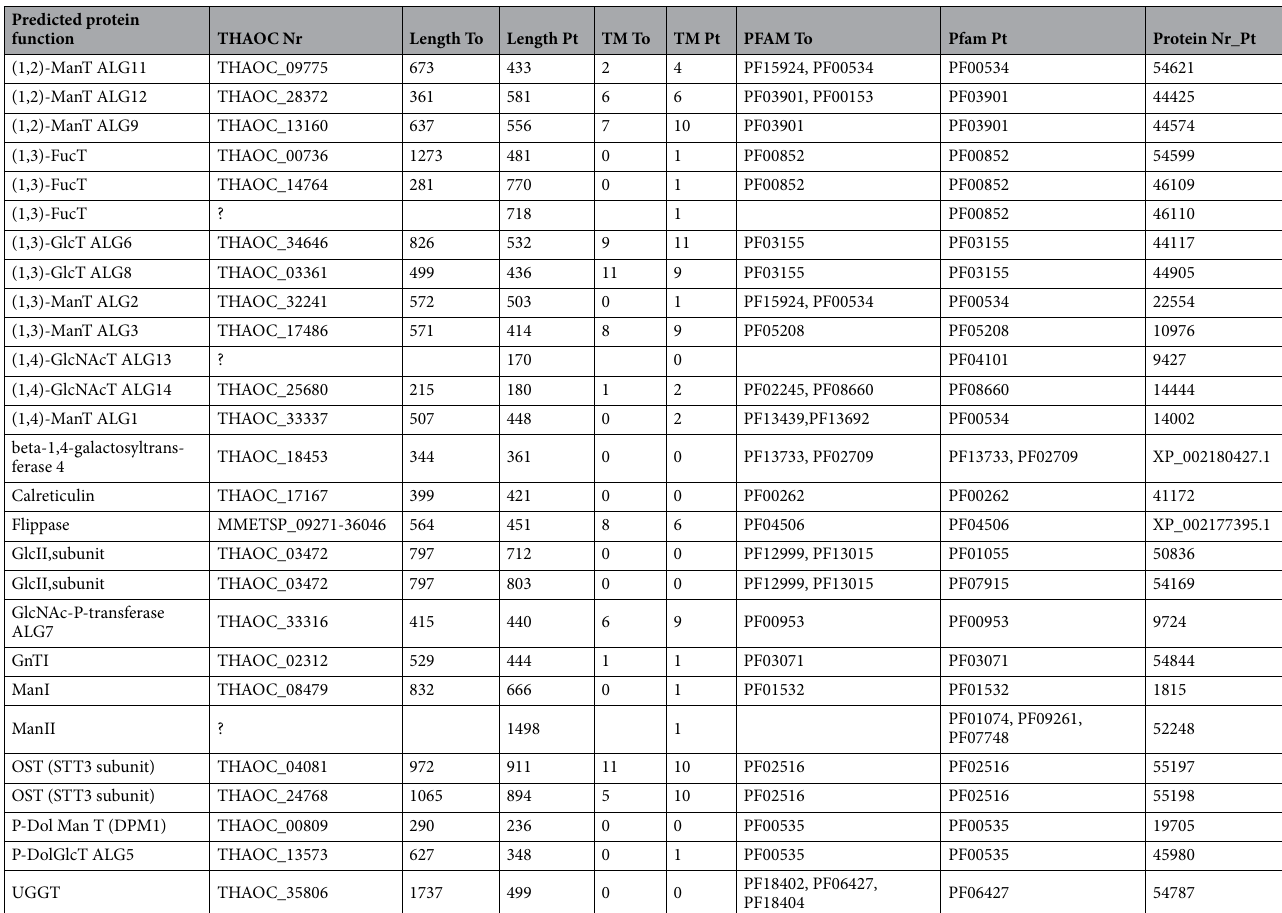
Table 1. Comparison of proteins involved in the N-linked glycosylation pathway between T. oceanica (this study) and P. tricornutum 4 . The table gives a comparison of previously published proteins that are involved in N-linked glycosylation in P. tricornutum 4 (Pt) and the corresponding proteins we discovered in T. oceanica (To). The table provides the length of the proteins (number of amino acids), the number of transmembrane domains (TM), the corresponding protein domains (PFAM), and the protein numbers (THAOC, Protein Nr.) The following abbreviations are used: N -acetylglucosaminyltransferase (GlcNAcT), mannosyltransferase (ManT), glucosyltransferase (GlcT), dolichol-phosphate –glucosyltransferase (P-Dol GlcT), dolichol-phosphate mannosyltransferase (P-Dol ManT), glucosidase II (Glc II), mannosidase I (Man I), N -acetylglucosaminyltransferase I (GnTI), mannosidase II (Man II), UDP-glucose glucosyltransferase